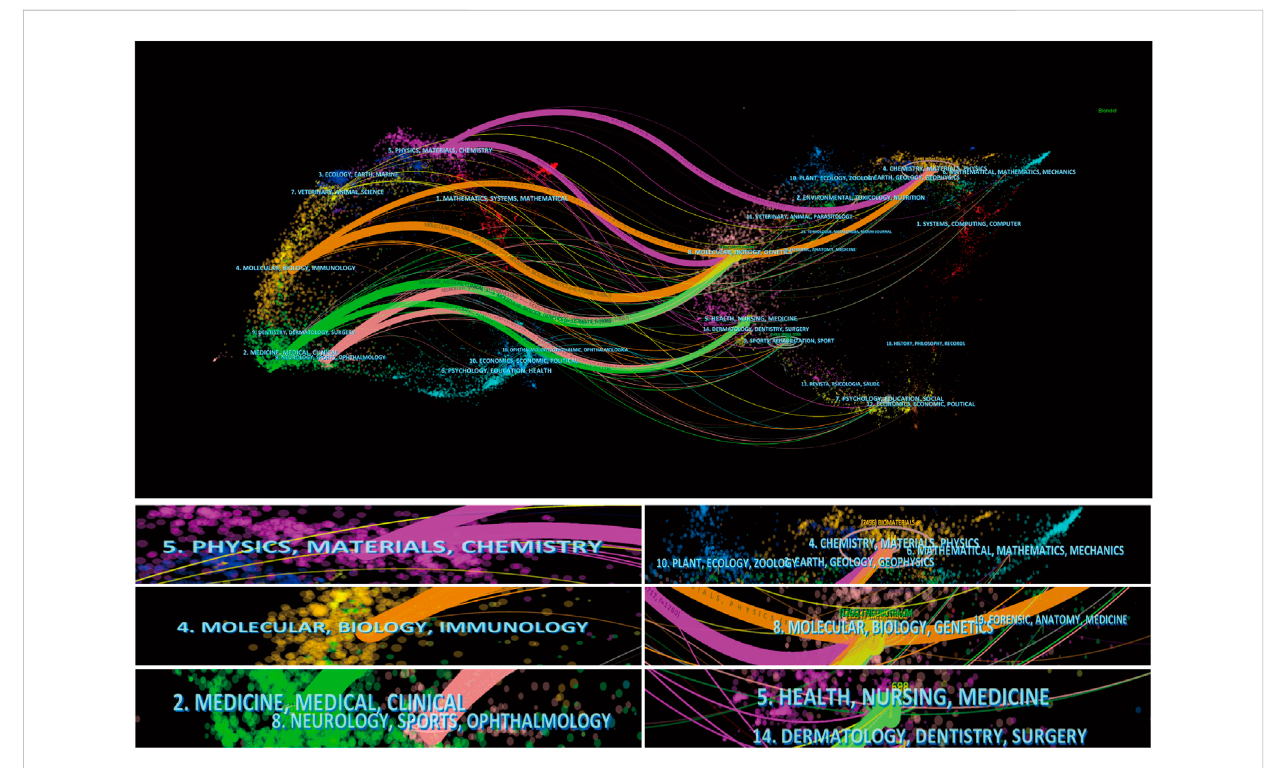
The dual-map overlay of articles citing (The left side were the right side were the cited journal, and the line path represents in the citation